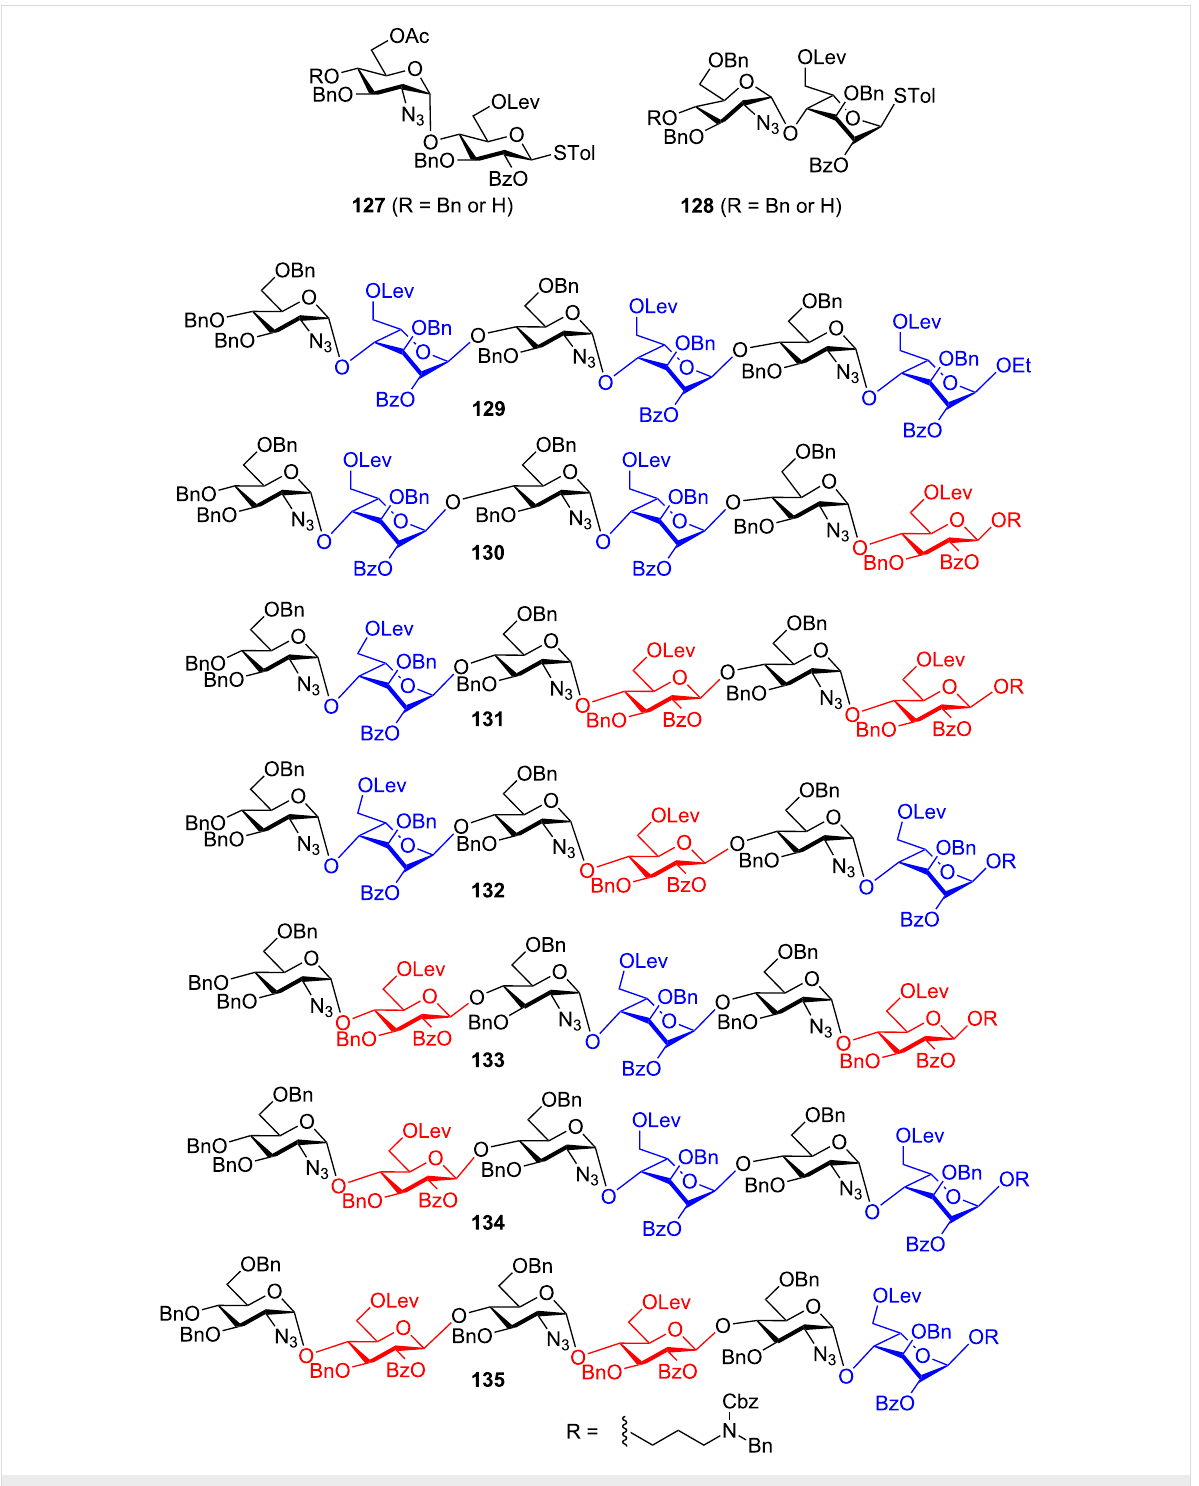
Figure 8: Preparation of a heparan sulfate oligosaccharides library.